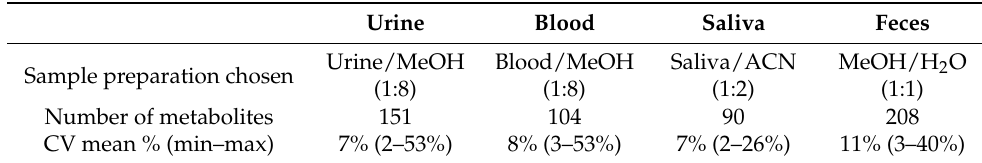
Table 1. Numbers of metabolites recovered in repeated samples compared to metabolites found in the chosen extraction protocol. Variation coefficients (CVmean) and (CVmin–Cvmax) were calculated from the fusion of the three platforms. Urine Blood Saliva Feces Sample preparation chosen